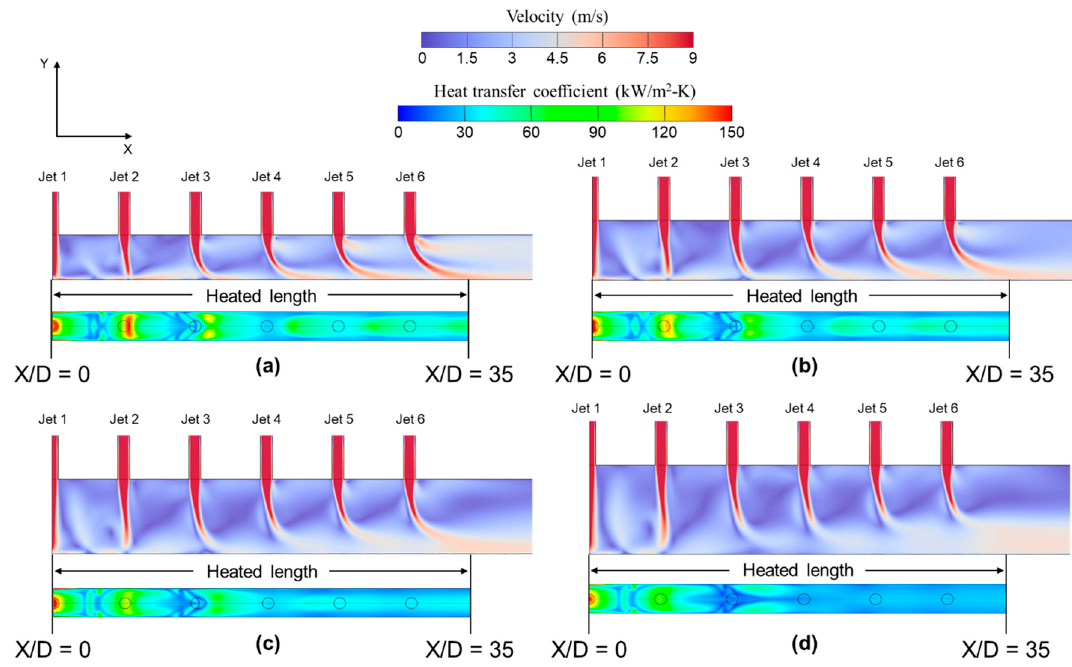
Figure 10. Velocity contours and wall heat transfer coefficient distributions at q ″ = 30 W/cm 2 and V jet = 9 m/s for ( a ) H ch = 3 mm; ( b ) H ch = 4 mm; ( c ) H ch = 5 mm; ( d ) H ch = 6 mm.